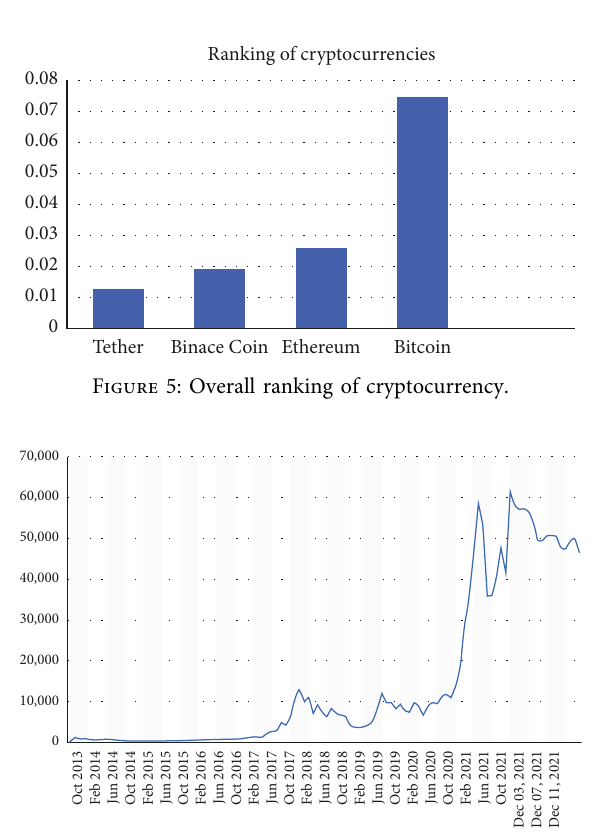
Figure 6: Bitcoin (BTC) price from 2013 to 2021 (source: price index data from CoinDesk